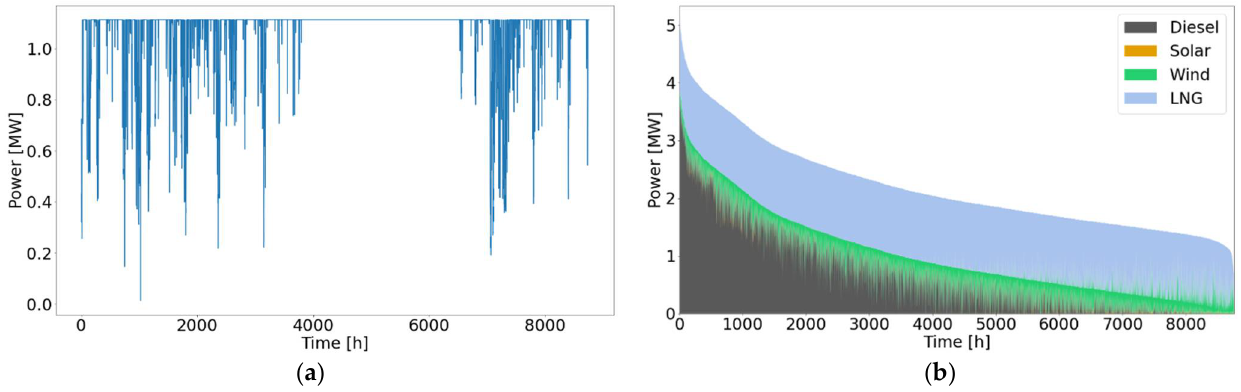
Figure 6. Resulting dispatch; ( a ) presents the yearly operation of the SOFC unit, and ( b ) presents the corresponding load duration curve.